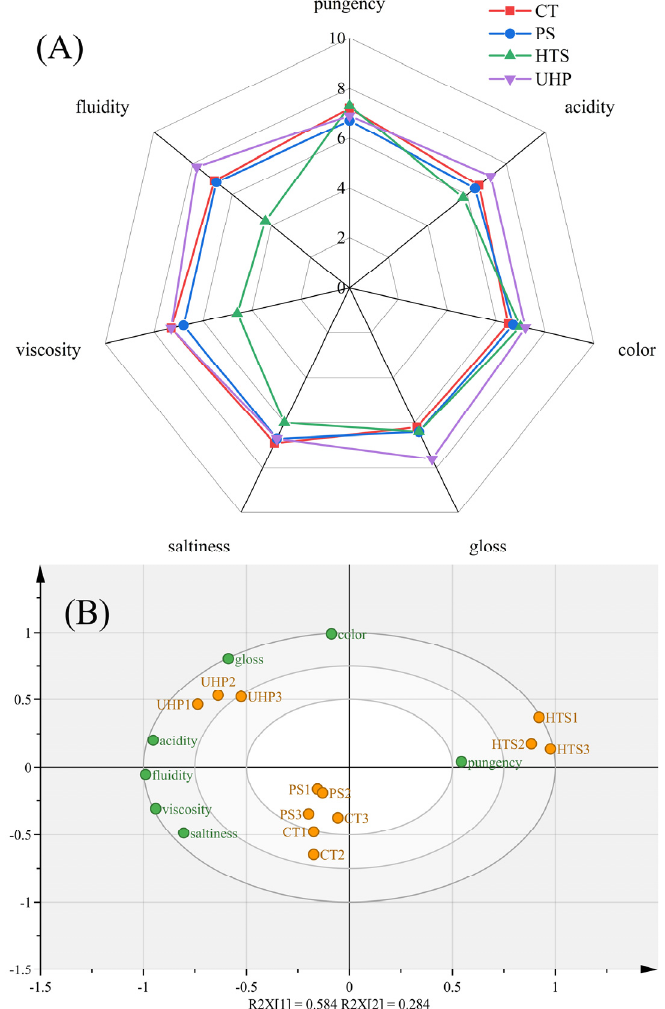
Figure 2. Sensory characteristics of the sauce by different sterilization methods ( A ) Spider web diagram; ( B ) PCA bi − plot generated from the sensory descriptors ( p < 0.05).